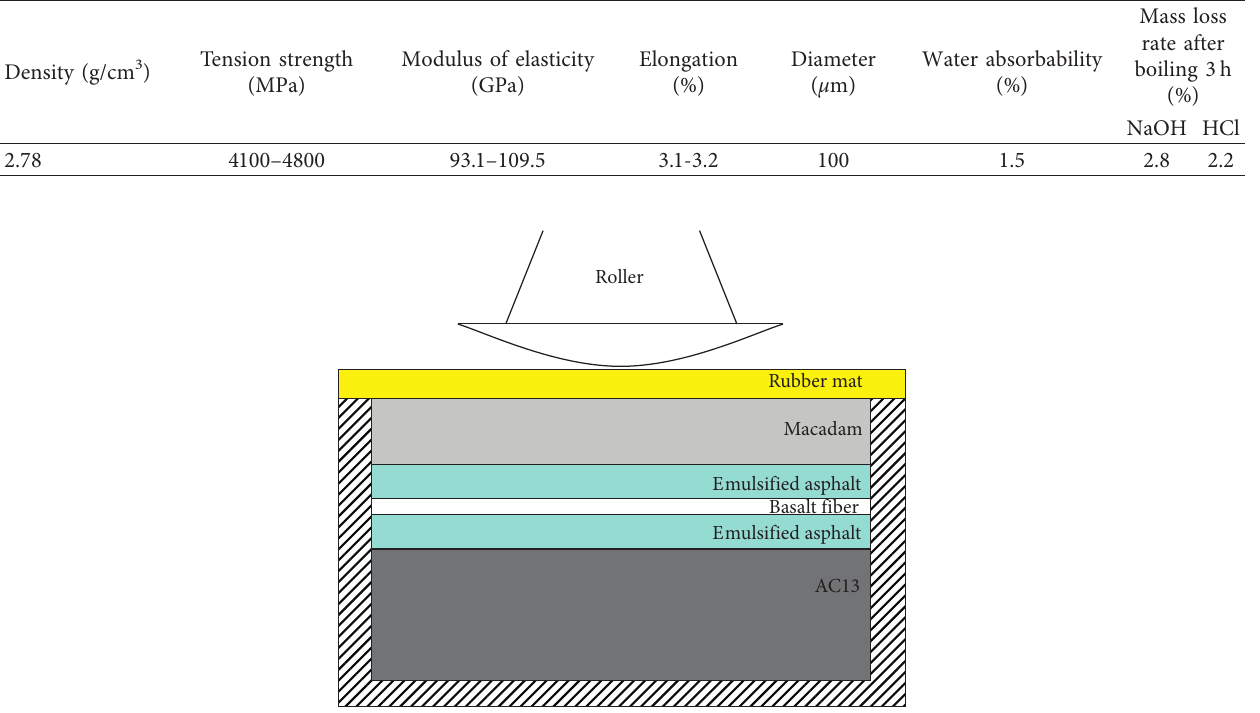
Figure 1: Structure and rolling test of the fiber macadam